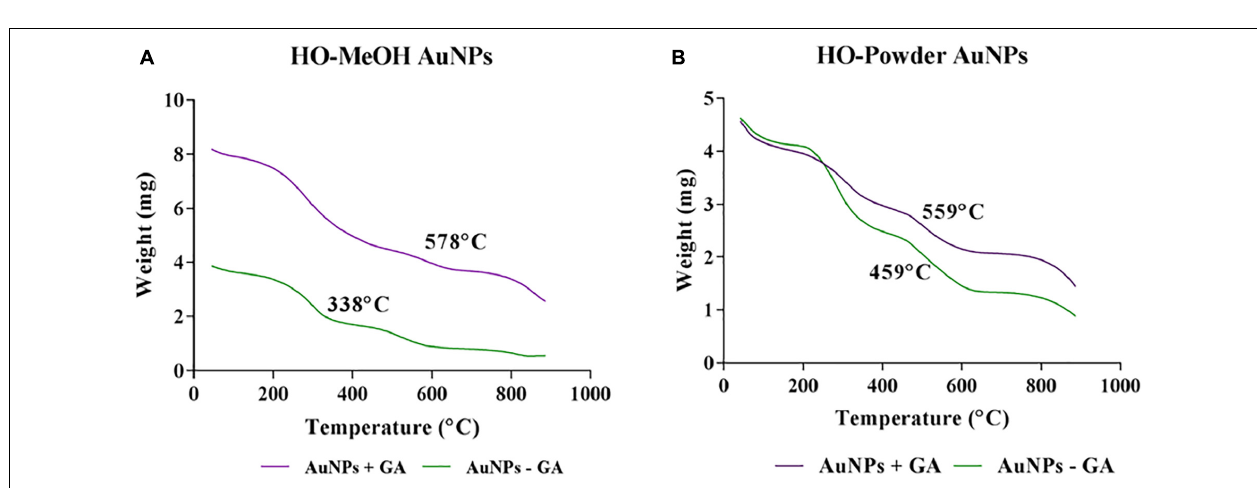
FIGURE 6 | The X-Ray Diffraction chromatograms of Helichrysum odoratissimum methanol extract gold nanoparticles (A) and H. odoratissimum leaf powder (B) gold nanoparticles. * Represents unidentified peaks in the XRD spectra that do not match with the face-centred cubic crystal structure of gold.